Question: Condense the content of this figure into a single sentence.
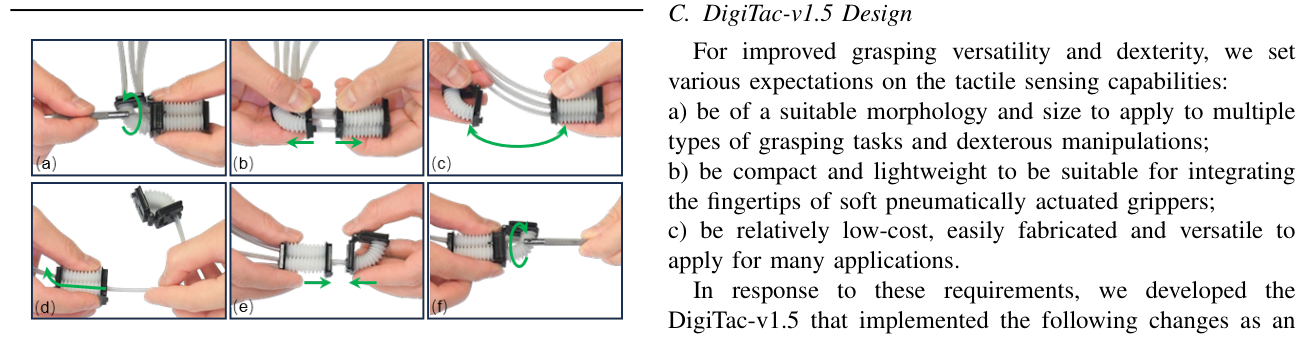
Answer: Reconfiguration process from Rot-Dex finger to Dex-Rot finger. (a) Unscrew the bolts. (b) Separate two joints. (c) Exchange places. (d) Enter the tube. (e) join the two joints. (f) screw the bolts.